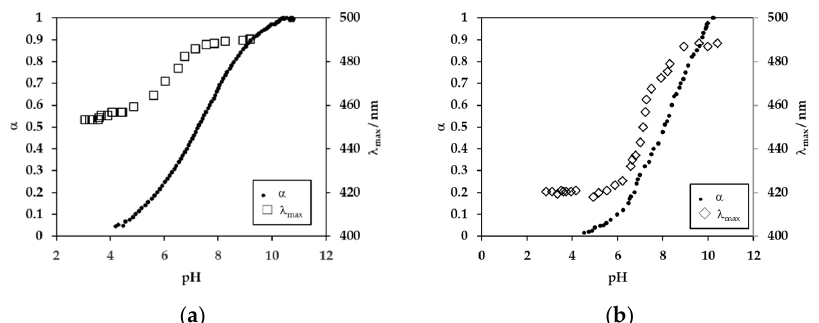
Figure 3. The fraction of dissociated carboxylic group ( α ) and fluorescence λ max values for 0.005 w/v% poly(VDP- co -carboxylic acids) solutions: ( a ) poly(VDP- co -AAc) and ( b ) poly(VDP- co -MAAc).